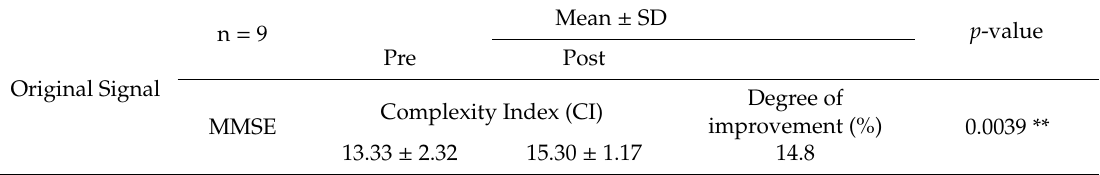
Table 3. The complexity index (CI) of multivariate multiscale entropy (MMSE) values.